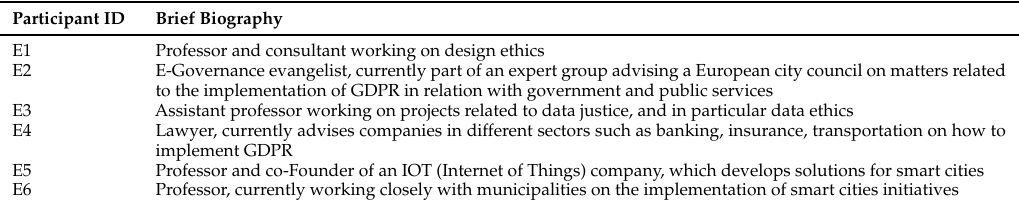
Table 1. Brief biographies of the experts